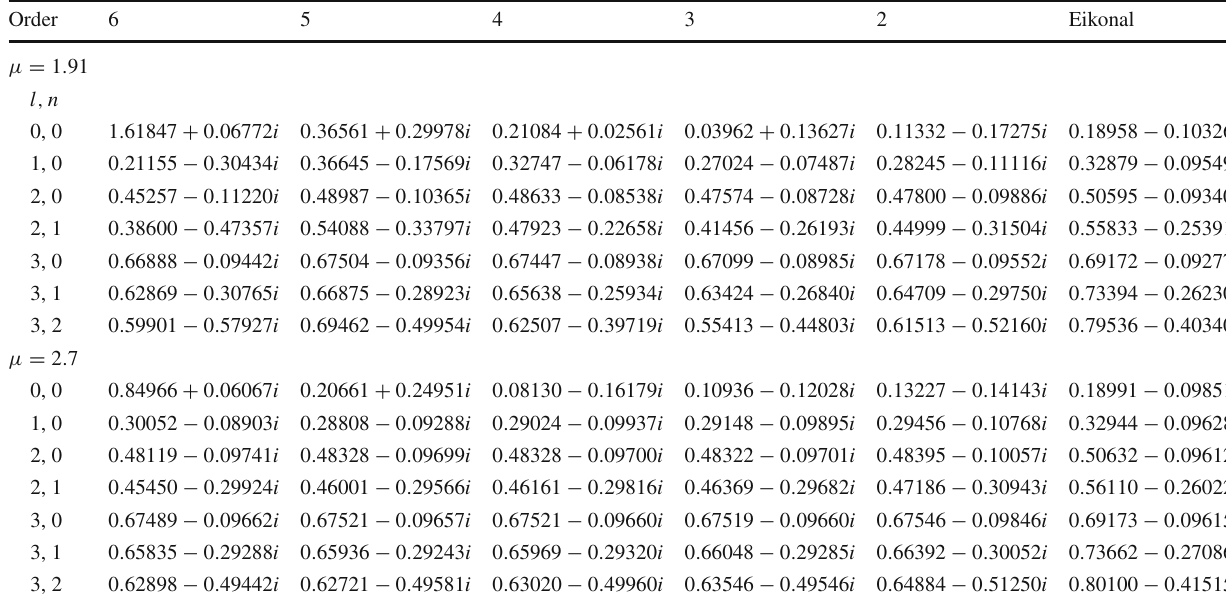
Table 3 QNMs at different orders of the WKB approximation